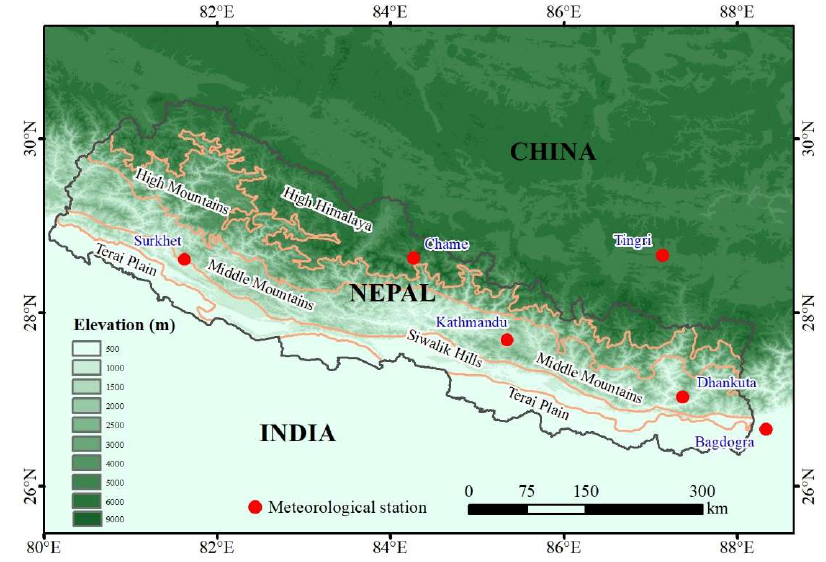
Figure 1. Elevation map and physiographical regions of Nepal. Note: the red points are meteorological stations.